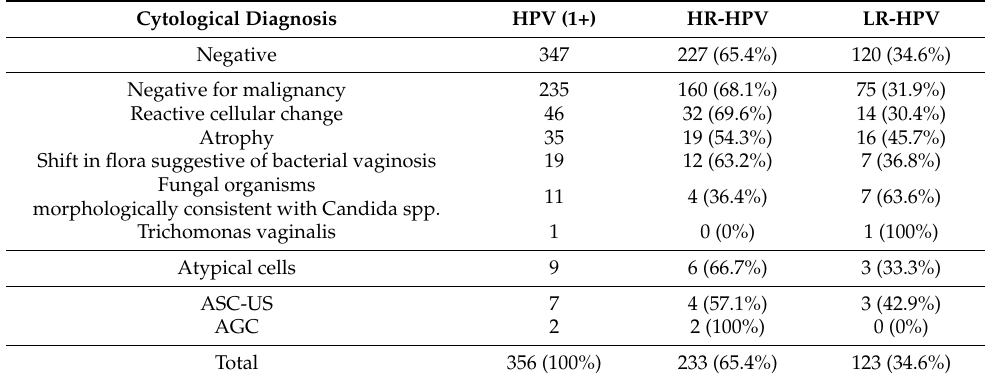
Table 3. Baseline cytological diagnosis in patients with low (1+) VL of